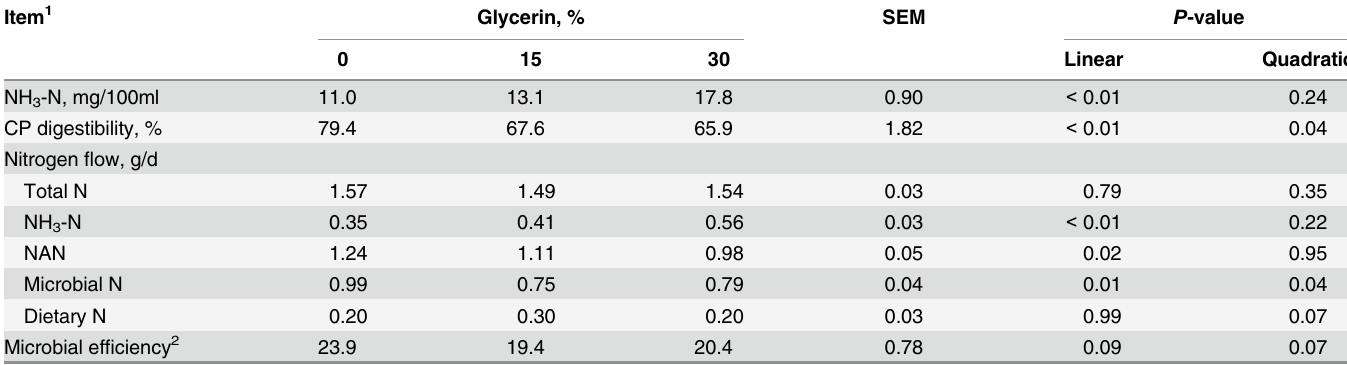
Table 4. Effect of glycerin inclusion on nitrogen metabolism of rumen microorganisms in dual-flow continuous culture system. Item